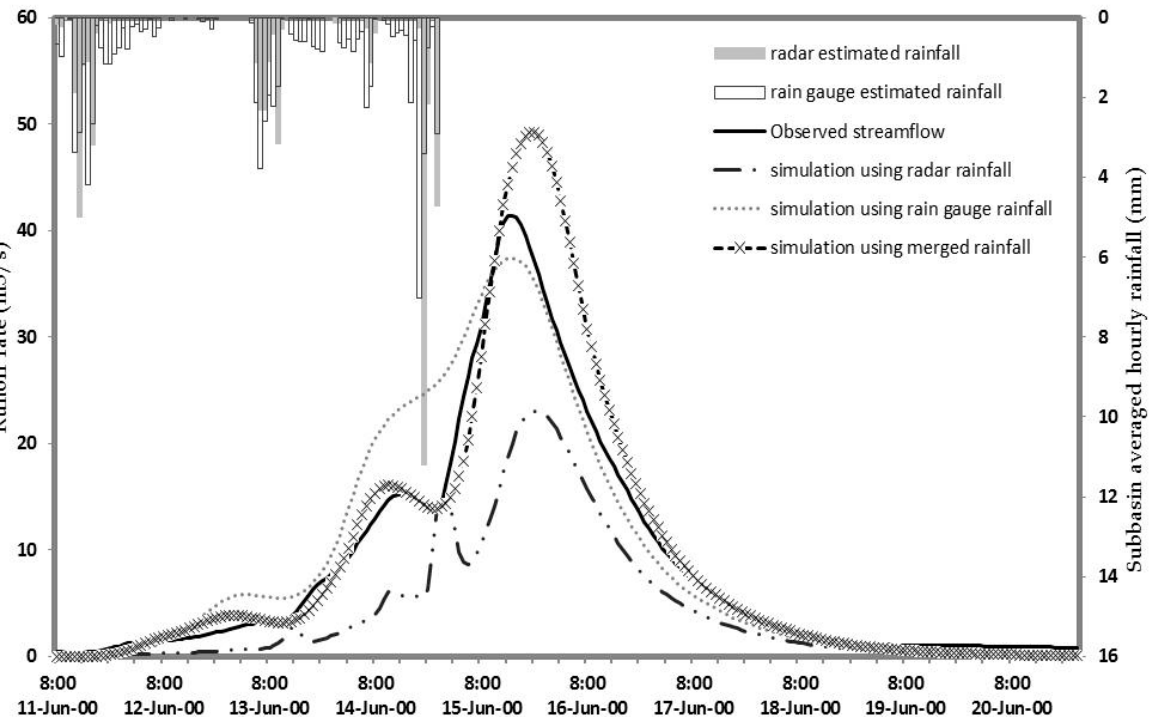
Figure 10. Comparison of estimated and observed hydrographs using different rainfall estimates for the 11 June 2000 event with SCS modeling option.